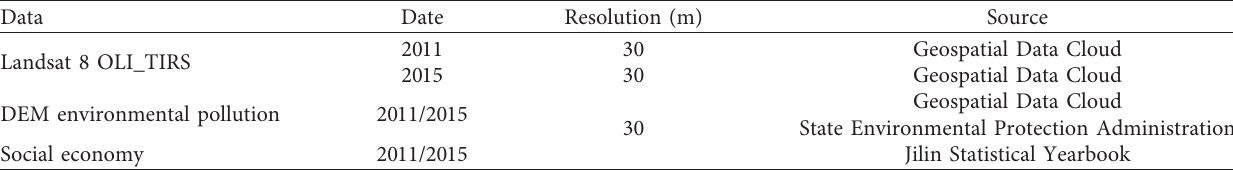
Table 1: Data sources and descriptions.